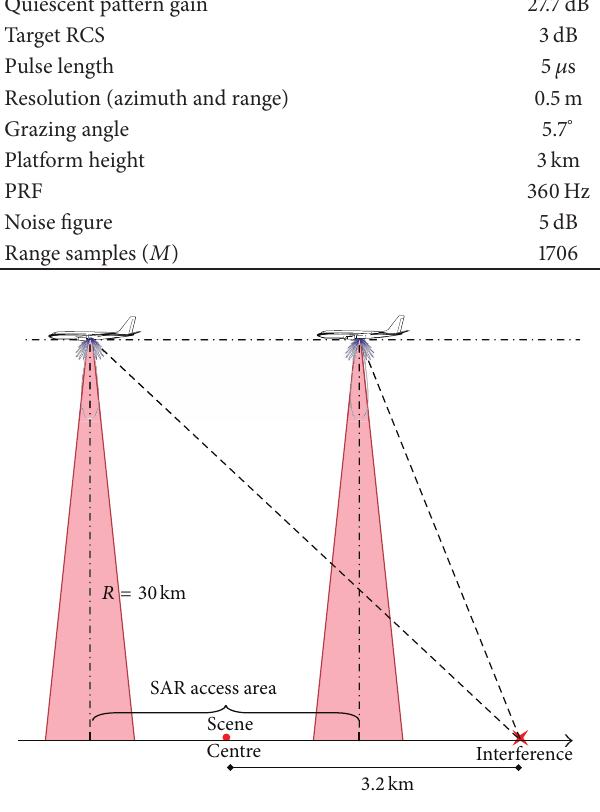
Figure 4: Jammer scenario.